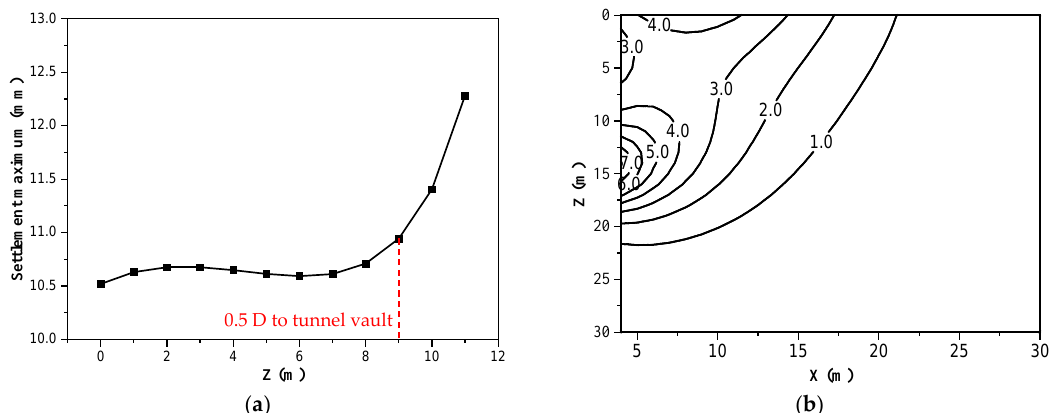
Figure 3. Displacement of stratum: ( a ) Variation curve of settlement maximum; ( b ) Counter map of horizontal displacement.